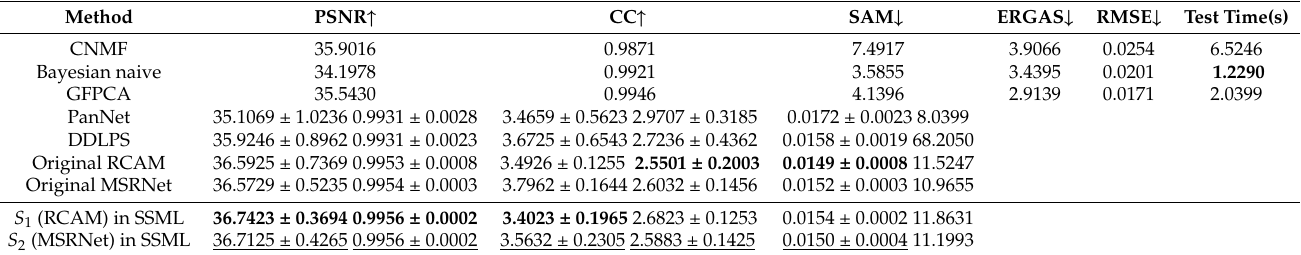
Figure 6. The visual results of different methods on the CAVE dataset. ( a ) CNMF; ( b ) Bayesian naive; ( c ) GFPCA; ( d ) PanNet; ( e ) DDLPS; ( f ) Original RCAM; ( g ) Original ResNet; ( h ) S 1 (SeAM) in the SSML framework; ( i ) S 2 (ResNet) in the SSML framework; ( j ) Ground truth. Note that the false color image is selected for clear visualization (red: 30, green: 20, and blue: 10). The even rows show the difference maps of the corresponding methods. Table 6. The quality indicator results of different methods on the CAVE data